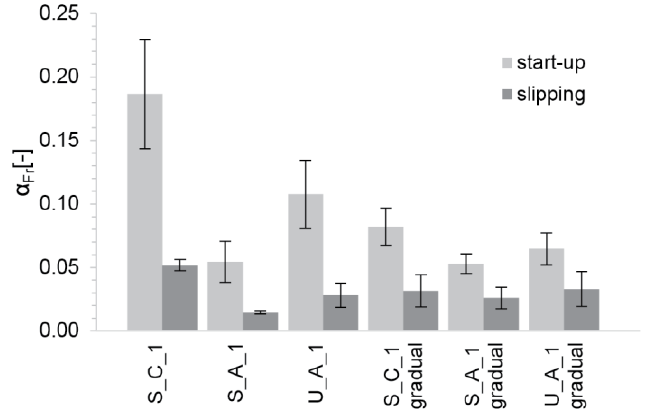
Figure 15. Frictional parameter calculated for each mix and filling method at the start and during slipping. The error bars represent the standard deviation of the α Fr parameters measured over time on the different friction strips.